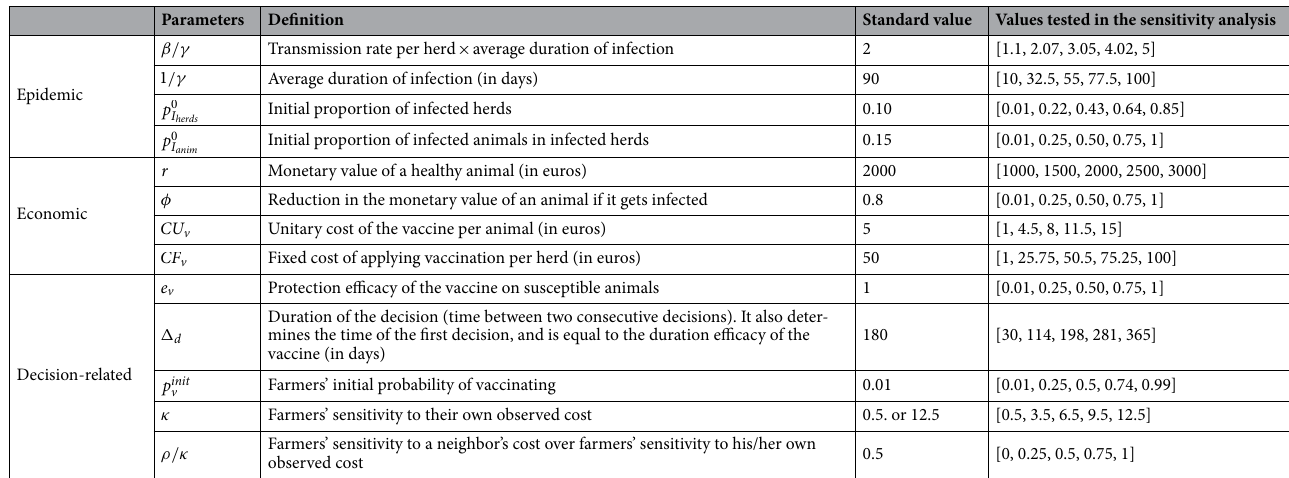
Table 1. Parameters of the integrative model: description, standard values and values tested in the full sensitivity analysis.